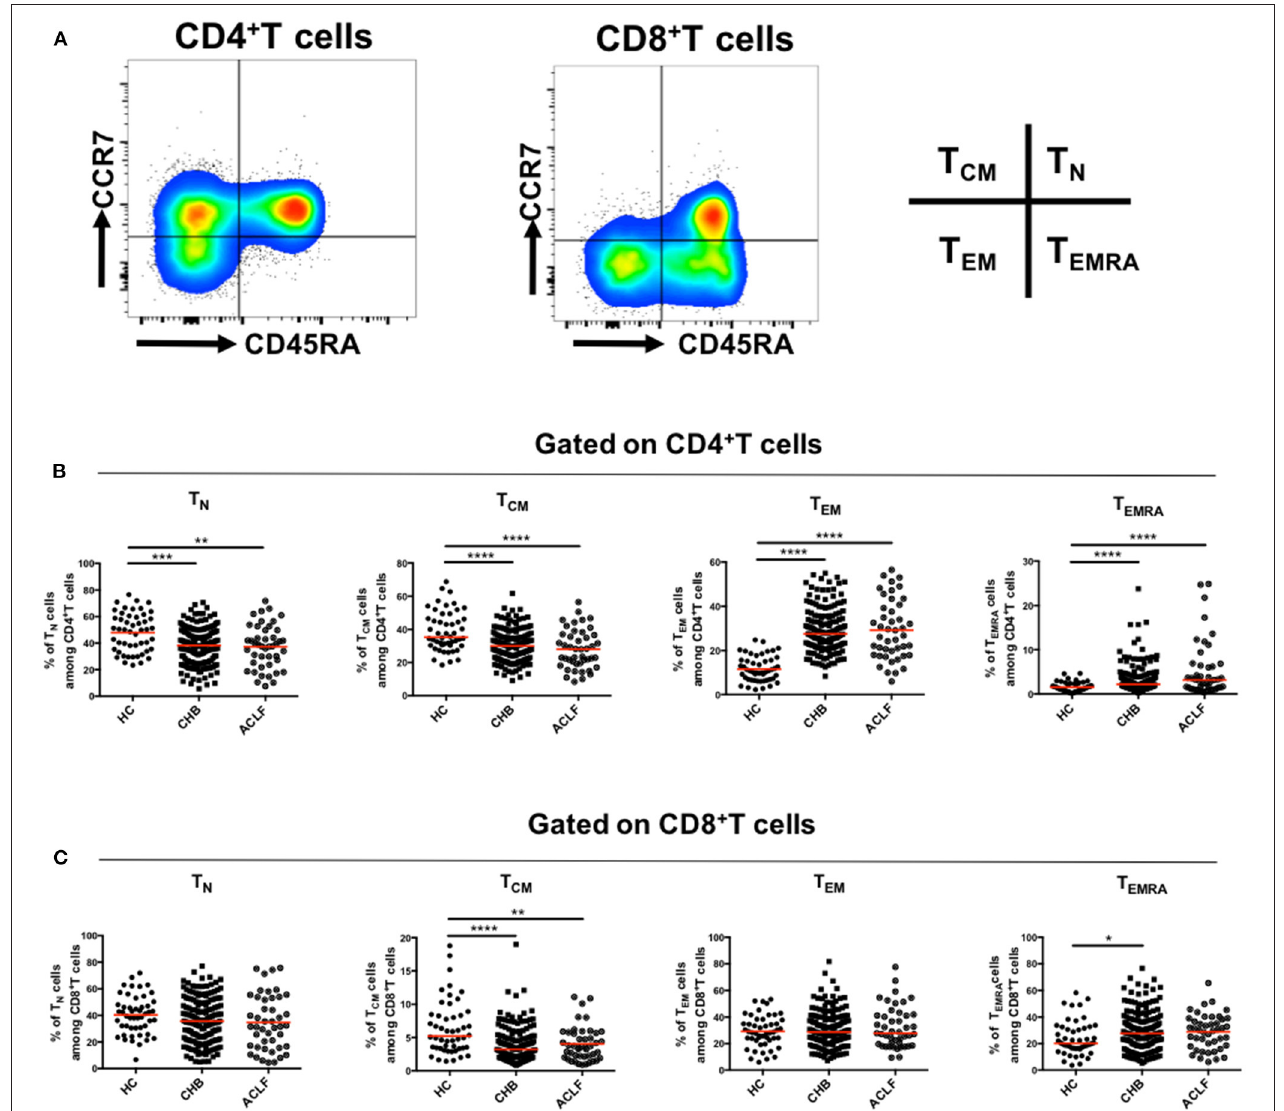
FIGURE 1 | Differentiation of circulating T cells. Representative flow data gated on CD4 + and CD8 + T cells (A) and scatter dot plots of the percentage of T N , T CM , T EM , and T EMRA subsets gated on CD4 + (B) and CD8 + T cells (C) in different groups. A one-way ANOVA or Kruskal–Wallis test was used to analyze statistical differences. * p < 0.05, ** p < 0.01, *** p < 0.001, **** p <